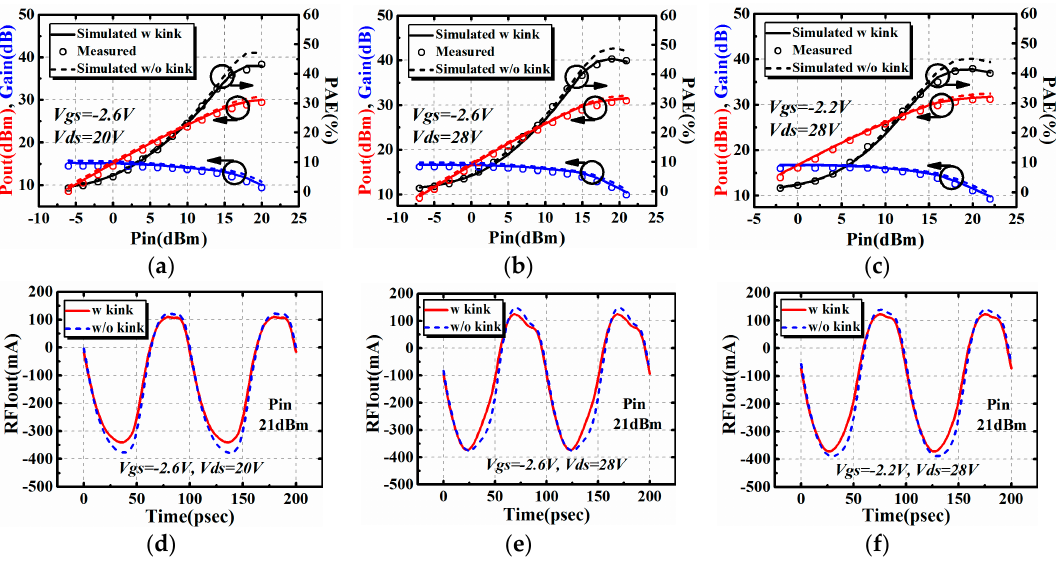
Figure 10. Investigation on the influence brought by the I–V kink effect at different bias points: ( a – c ) refers to the large signal output performance while ( d – f ) refers to the time domain waveform. Table 2. The influence of I–V kink effect on power-added efficiency.